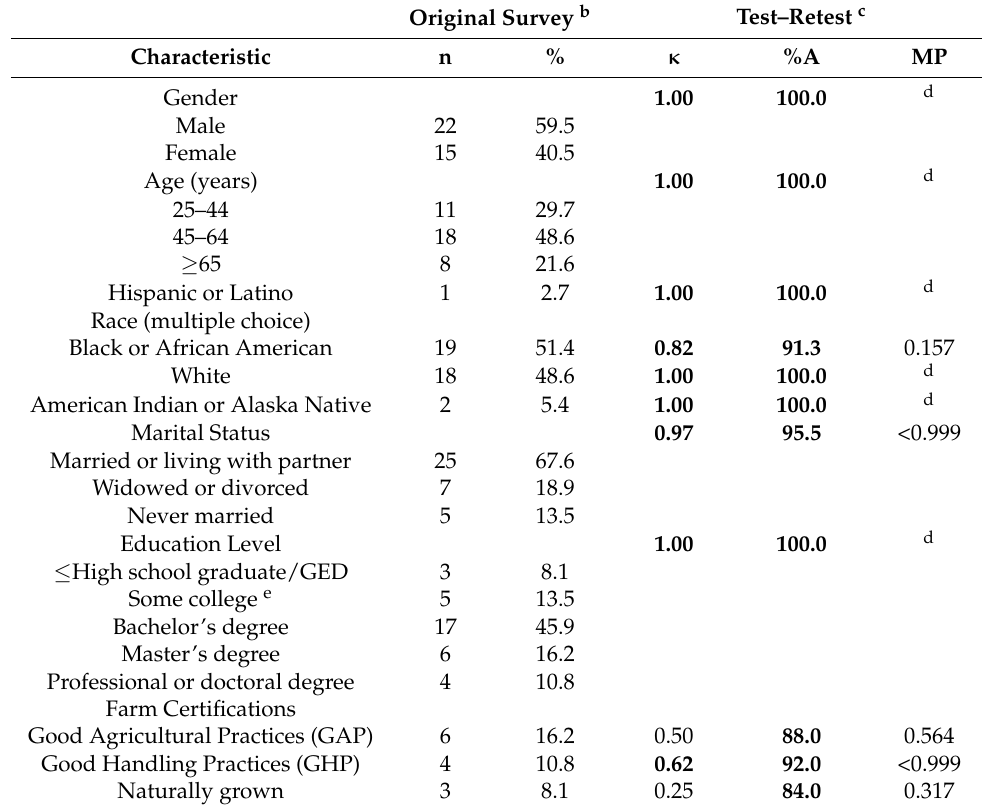
Table 1. Participant and Farm Characteristics with Test–Retest Statistics a : Mississippi Farm to School Small Farmer Survey